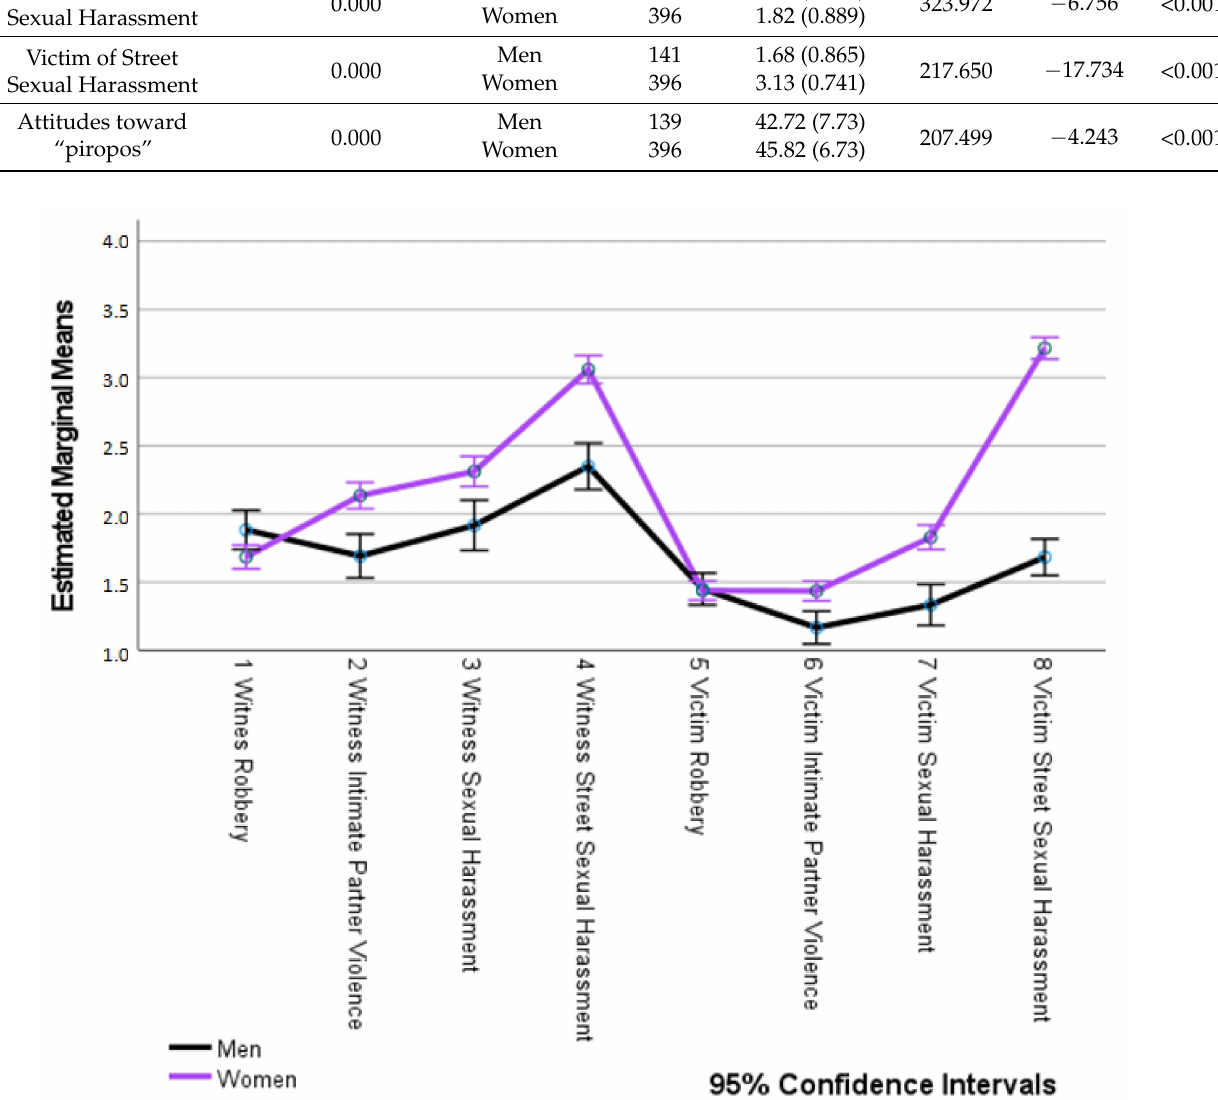
Figure 3. Differences in victimization types by